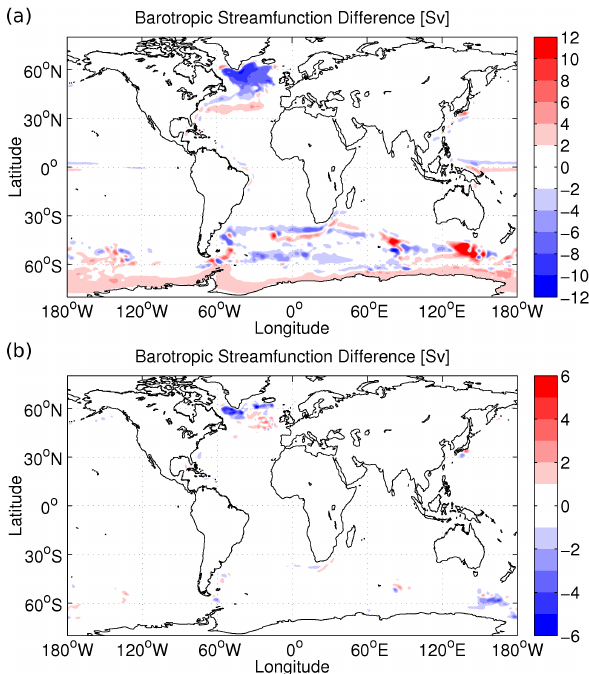
Fig. 113. (a) Barotropic streamfunction difference (Sv) between Fig. 13. (a) Barotropic stream function difference (Sv) between runs runs with Laplacian and biharmonic Smagorinsky viscosities (the with Laplacian and biharmonic Smagorinsky viscosities (the latter latter minus former). (b) The same as in (a) but between a run with minus the former). (b) The same as in (a) but between a run with biharmonic viscosity scaled with third power of the horizontal res- biharmonic viscosity scaled with third power of the horizontal res- olution and a run with biharmonic Smagorinsky viscosity (the latter olution and a run with biharmonic Smagorinsky viscosity (the latter minus the former). The results are the last 10yr mean in 60yr sim- minus former). The results are the last 10 yr mean in 60 yr simula- tions.